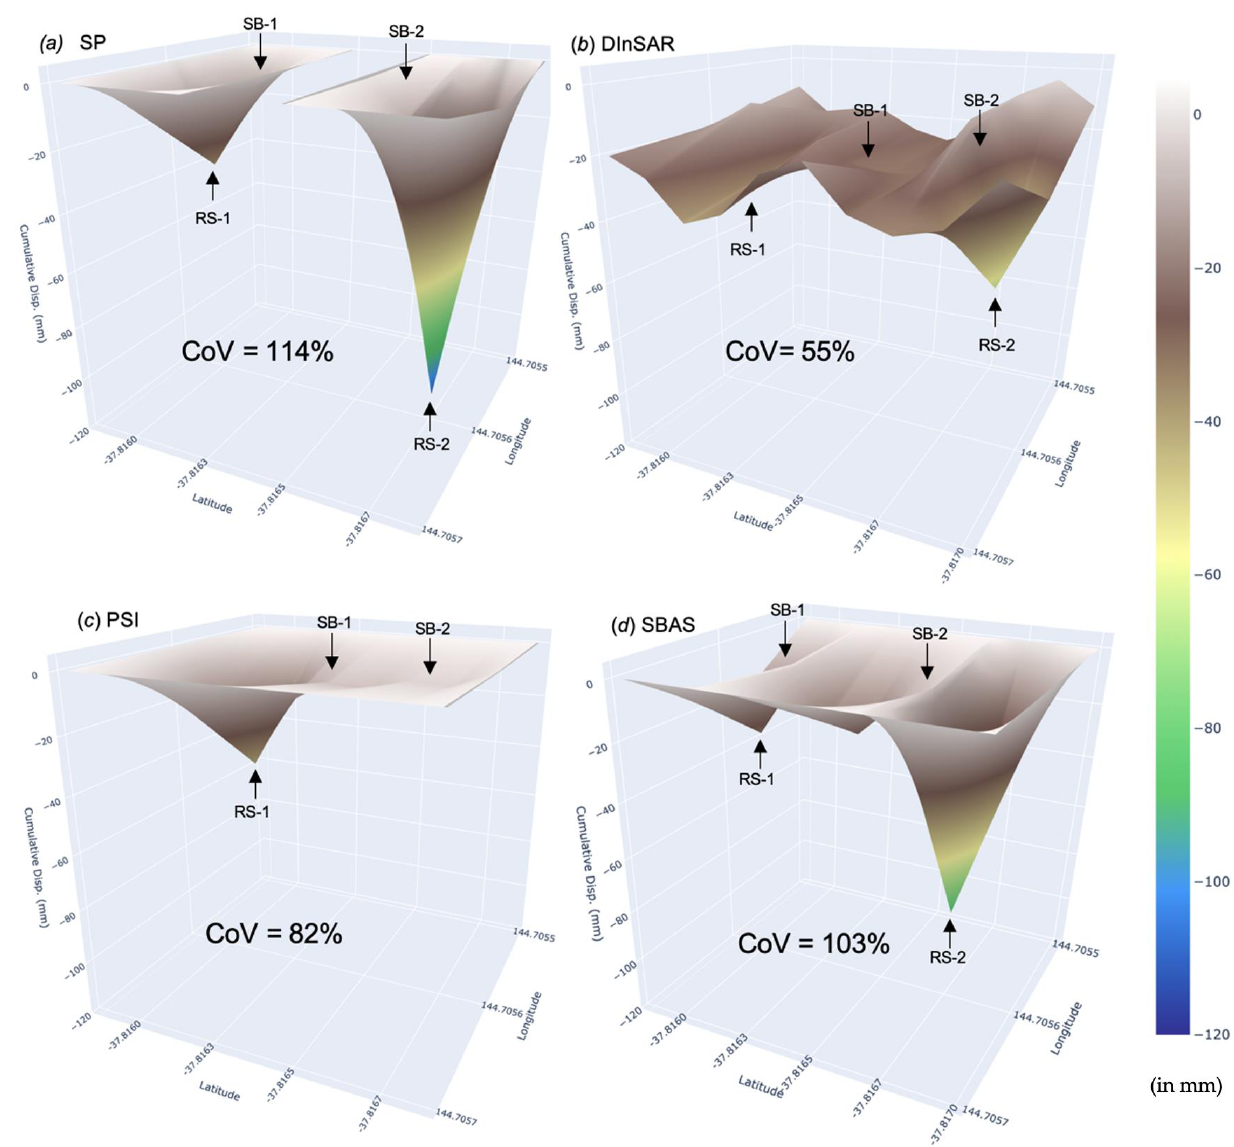
Figure 13. The final spatiotemporal variation of ( a ) SP, ( b ) DInSAR, ( c ) PSI and ( d ) SBAS. To investigate the spatiotemporal variation of the measured SP and the estimated InSAR values, the spatial CoV of the cumulative ground movement of the whole study site strip, Area 1, and Area 2 (described in Figures 1 and 2) were calculated for the early